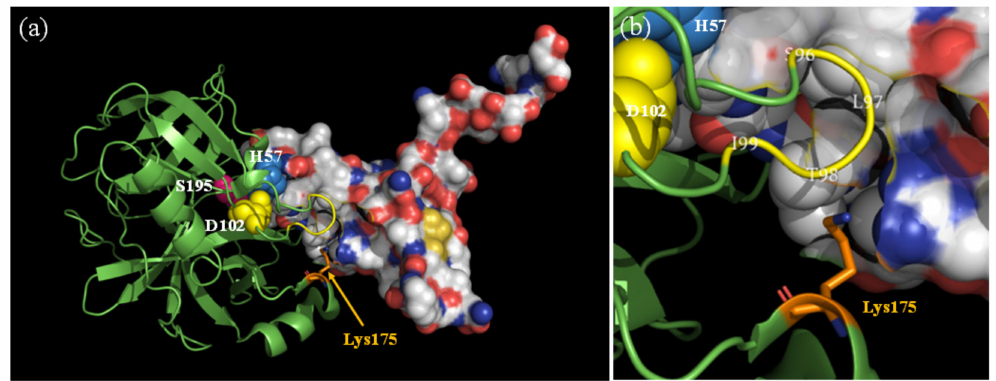
Figure 10. Crystal structure of Csin–BBI complex (PDB ID: 5J4Q [28,29]) by Johansson and Tornoee. ( a ) Structure of Csin (green) shown in solid ribbon format with catalytic triad (Ser195, magenta; HIs57, blue; Asp102, yellow) and Lys175 (stick, orange). Structure of BBI is shown in molecular surface and CPK format. ( b ) Diagram near Lys175. The side chain of Lys175 is in close proximity to the loop region (Ser96-Ile99,